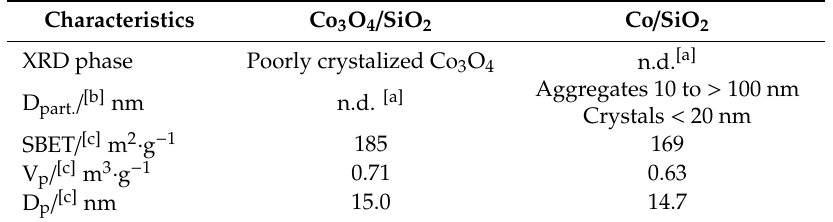
Figure 1. X-Ray Diffraction analysis of non reduced Co/SiO 2 catalyst (vertical bars, Co 3 O 4 reference PDF file 01-1152).